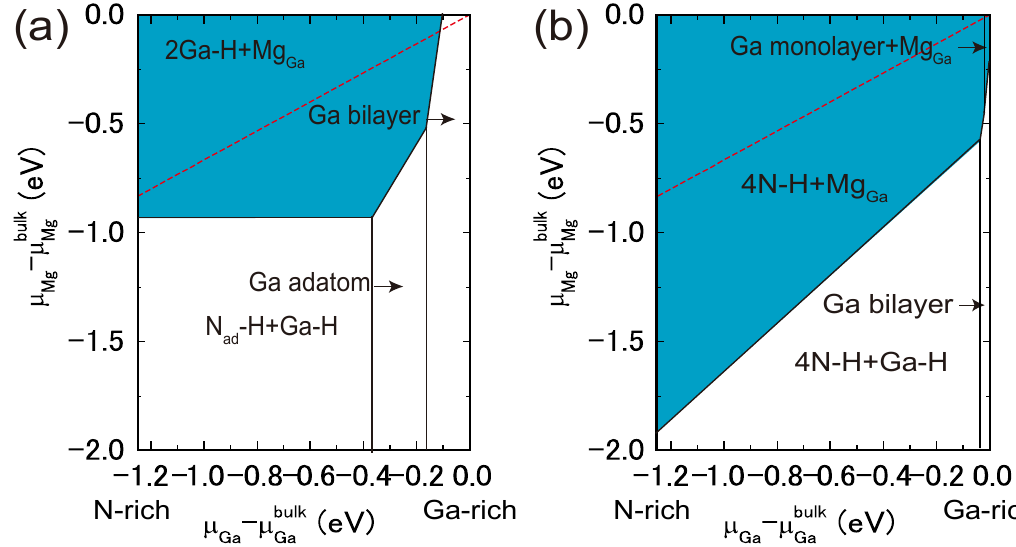
Figure 35. Stable Mg-incorporated structures on ( a ) GaN(0001) and ( b ) GaN (cid:4666)11(cid:3364)01(cid:4667) surfaces as a function of Ga chemical potential, μ high H pressure conditions ( μ 2 molecule). The stable regions of Mg-incorporated surfaces are emphasized by the shaded